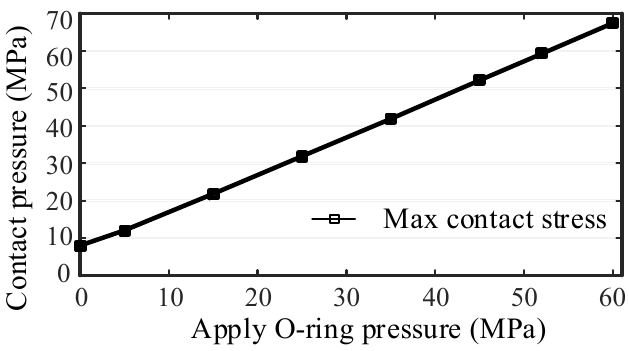
Figure 13. Contact pressure affected by fluid pressure. The internal equivalent stress of the O-ring is closely related to the initial pre-compression amount. As the fluid pressure increases, the internal equivalent stress of the O-ring begins to increase rapidly. The O-ring is deformed significantly under high-pressure medium, and the O-ring is further compressed, resulting in an increase in the internal equivalent force. When the internal equivalent stress increases to a certain extent, the deformation of the O-ring will become smaller and smaller, therefore, the internal equivalent stress will gradually stabilize. The contact surface pressure between the O-ring, the flange and the spherical body will increase with the increase of the fluid pressure acting on the surface of the O-ring, and the two show a linear trend. Therefore, the contact pressure p seal will always be greater than the fluid pressure p w as far as the pressure allows. The O-ring requires sufficient sealing contact area (contact width) in terms of sealing requirements, that is, the O-ring is required to have sufficient compression, the smaller the compression, the smaller